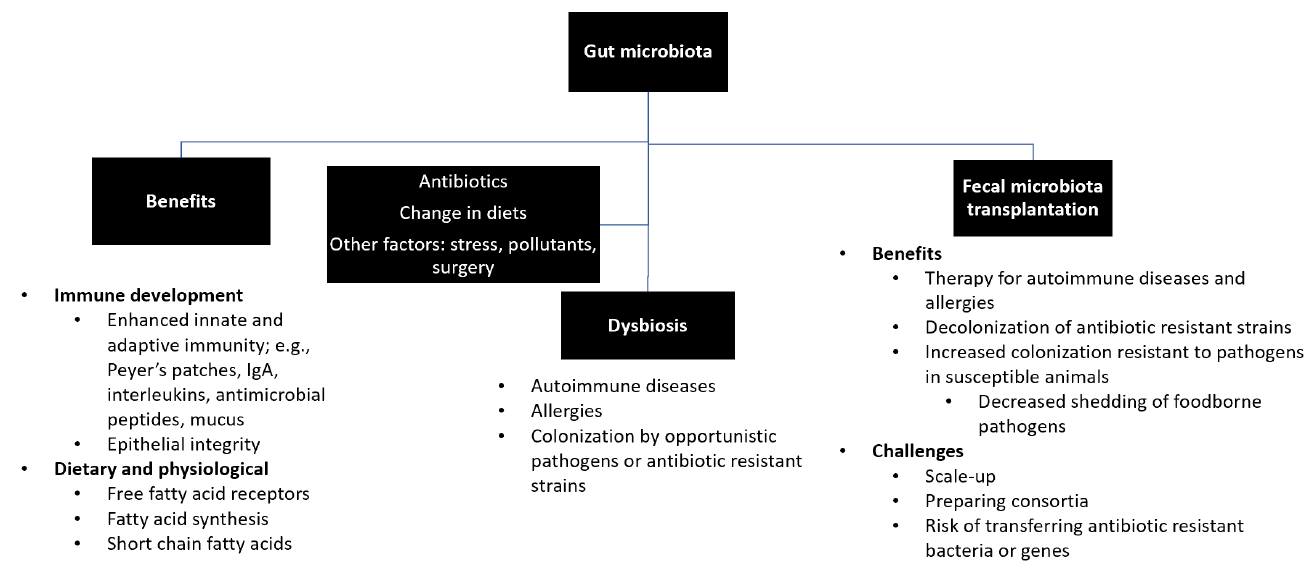
Figure 1. Summary of gut microbiota. Gut microbiota plays beneficial roles in the development of immune system, production and synthesis of essential nutrients, and maintenance of a healthy physiological status. Exposure to antibiotics and changes in diets and lifestyles may lead to disruption of healthy microbial diversity and composition (i.e., dysbiosis), which can be restored by fecal microbiota transfer.